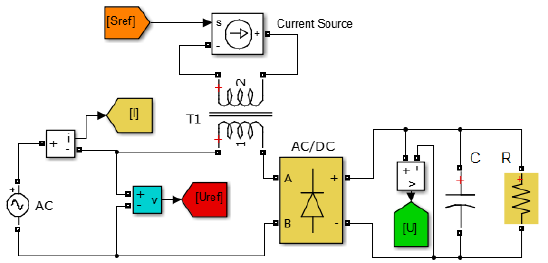
Fig. 3. Simulation model of one-phase full bridge rectifier with current modulator.